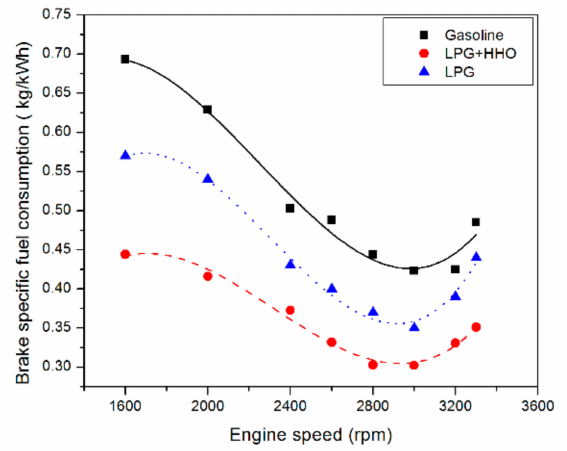
Figure 3. Comparisons of brake specific fuel consumption (BSFC) and engine speed for gasoline, LPG and LPG-HHO